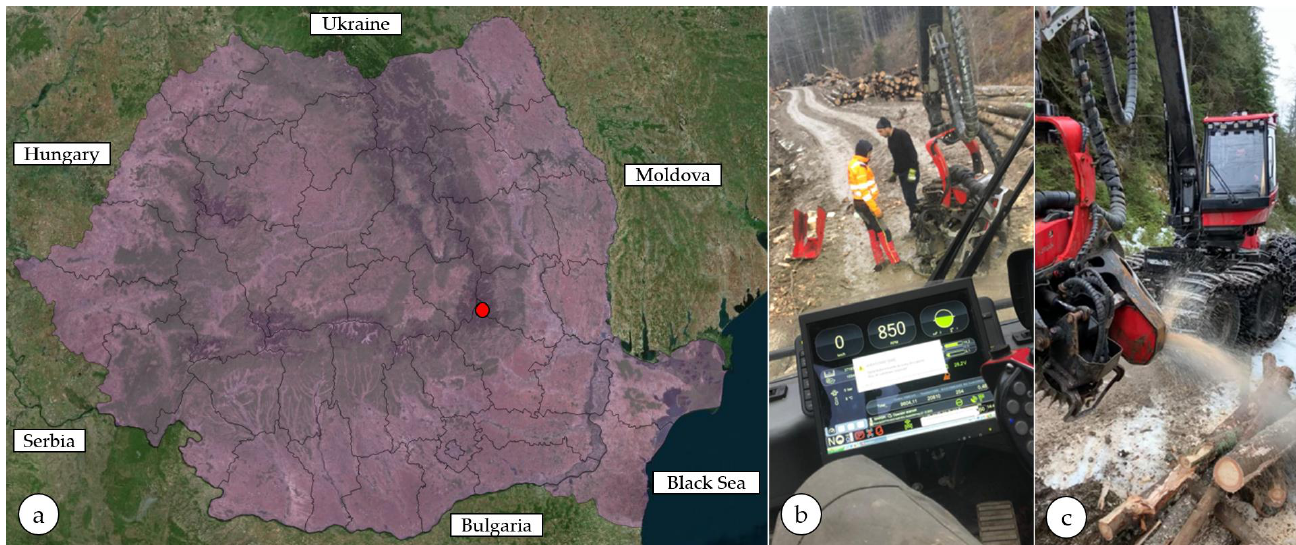
Figure 1. Study location: ( a ) location of the study area at the national level (red dot stands for the area of study — map designed in QGis based on open-source data); ( b ) a snapshot of the workplace, including the bunches of stems placed along the forest road; ( c ) a snapshot of the machine during the operations.